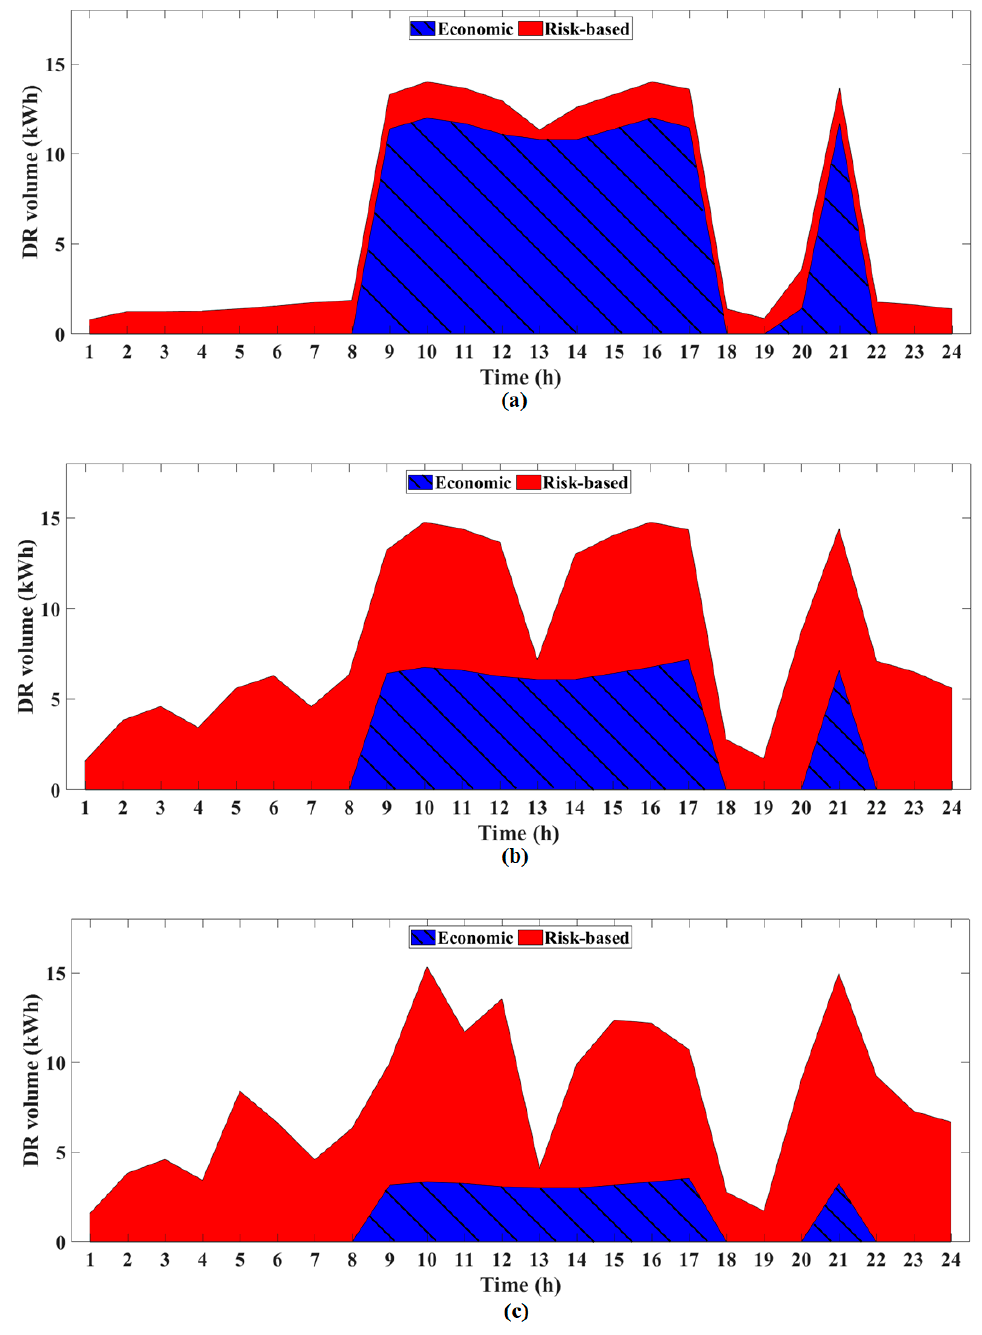
Figure 10. Optimal risk-based hybrid demand response program (RH-DRP) participation volume. ( a ) β = 0.1, ( b ) β = 0.5, and ( c ) β = 1.